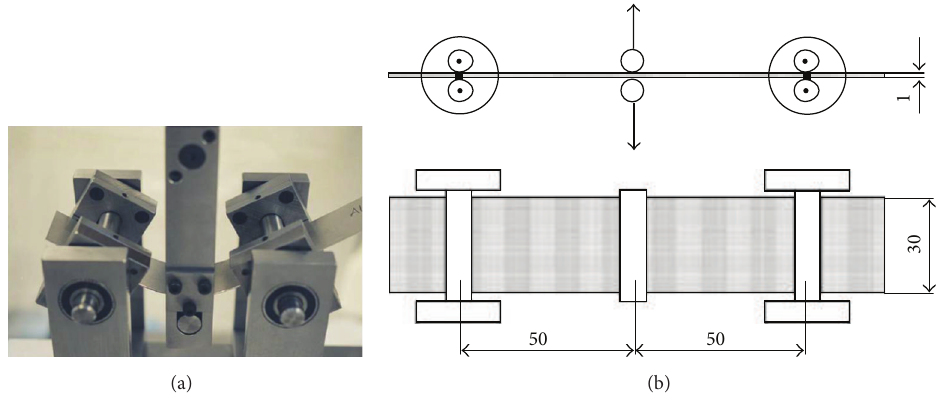
Figure 5: Device for three-point bending test [54]: (a) experimental setup and (b) schematic representation of horizontal and vertical